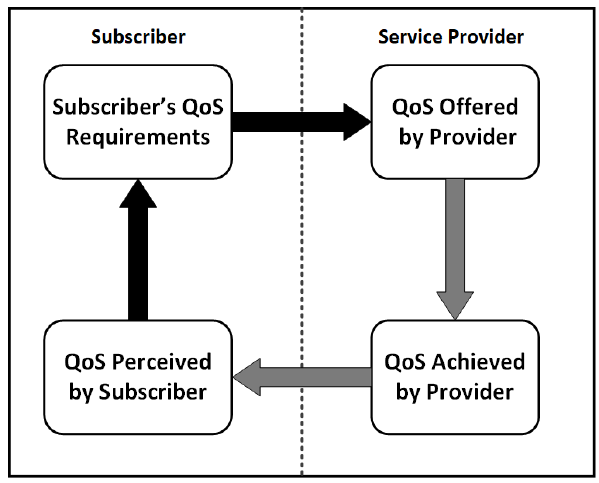
Figure 2. The four QoS viewpoints. Table 5. Technical and non-technical aspect of QoE.